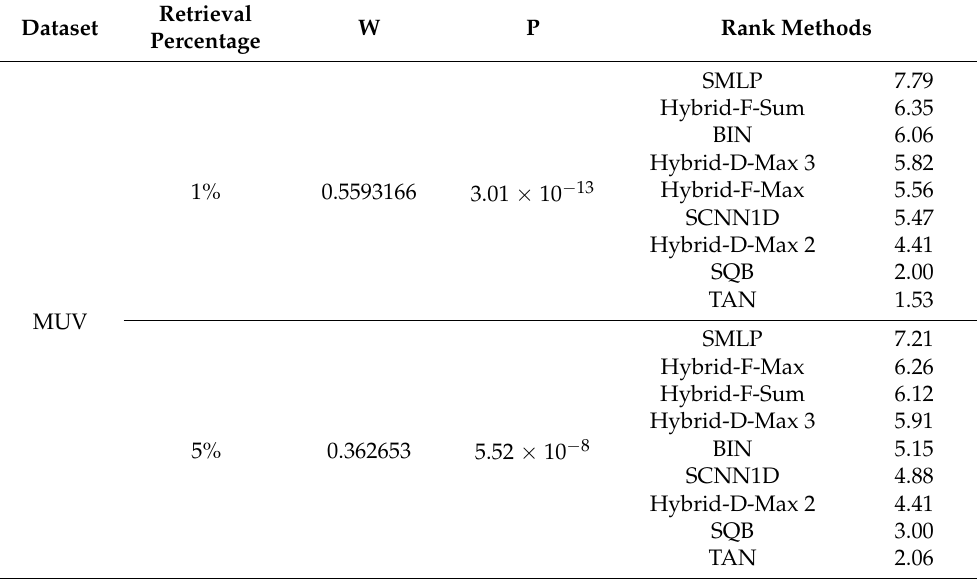
Table 16. Ranking of hybrid Siamese similarity models based on (TAN, BIN, SQB, SCNN1D, and SMLP) using Kendall W test results for MUV, at top 1% and